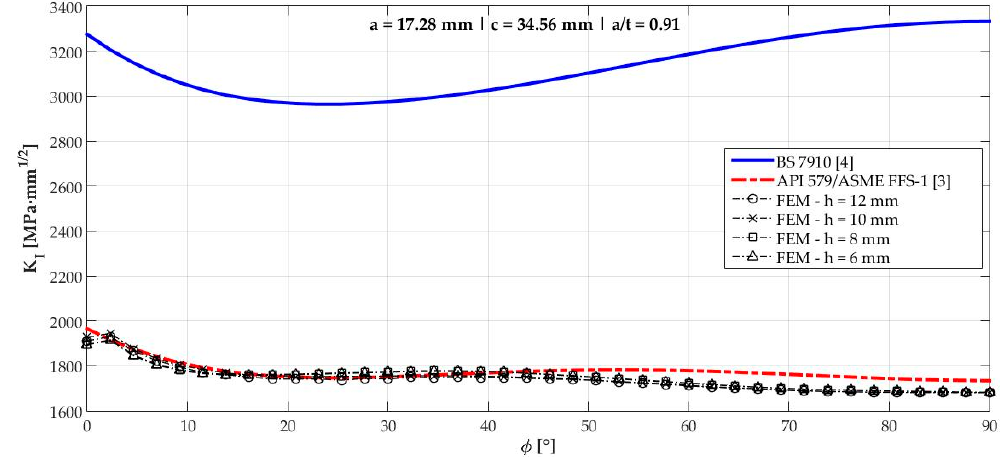
Figure 16. Mode I SIF profiles for crack 11 ( a = 17.28 mm , c = 34.56 mm , and a/t = 0.91 ).